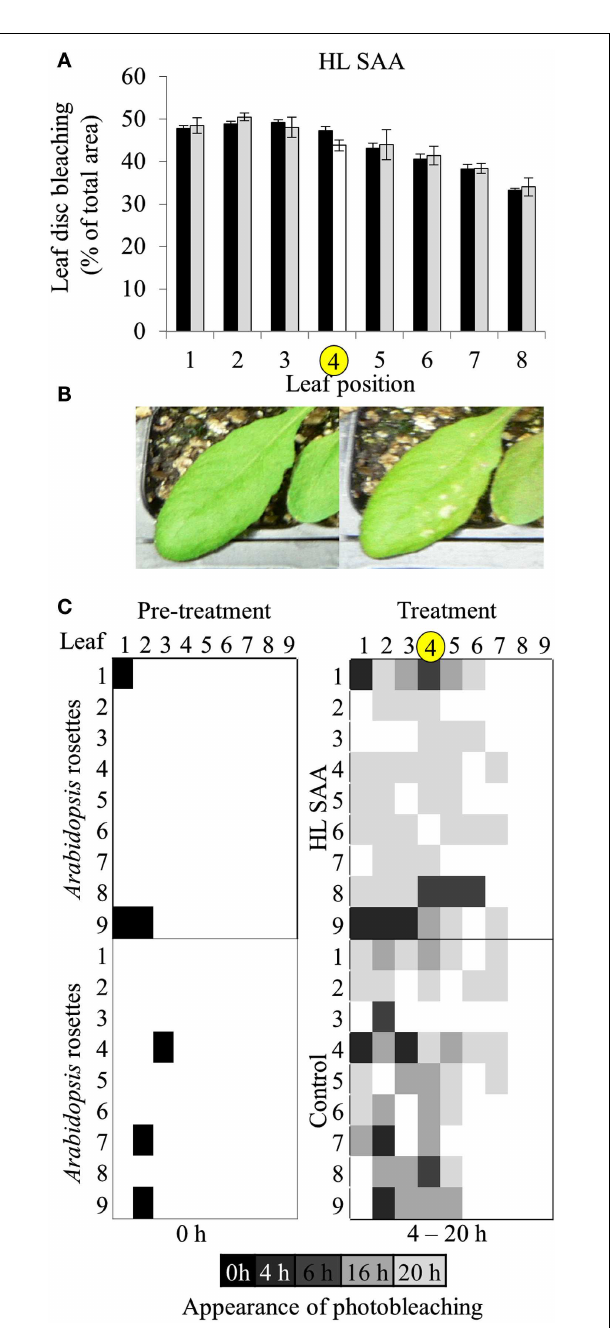
HL SAA. (A) In vitro photo-oxidative stress tolerance leaf disk assay, Arabidopsis plants were either HL SAA treated at leaf position 4 (white bar, yellow circle) or remained untreated (black). Leaf disks were then taken from all leaves, including distal (gray), floated on H 2 O 2 , and assayed as in Figure 5 . Photographs of the leaf disks taken after 20h and were analyzed using ImageJ software to calculate the percentage of healthy and bleached tissue, n = 3. (B) First signs of photobleaching during the in vivo assay. (C) In vivo temporal assay of photobleaching development based on leaf position comparing HL SAA treated (top panels) and non-acclimated control plants (lower panels), n =